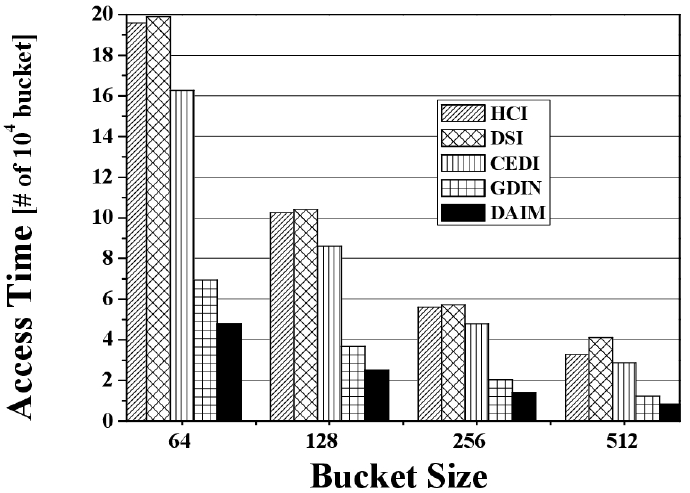
Figure 8. The comparison of the access time over various bucket sizes.